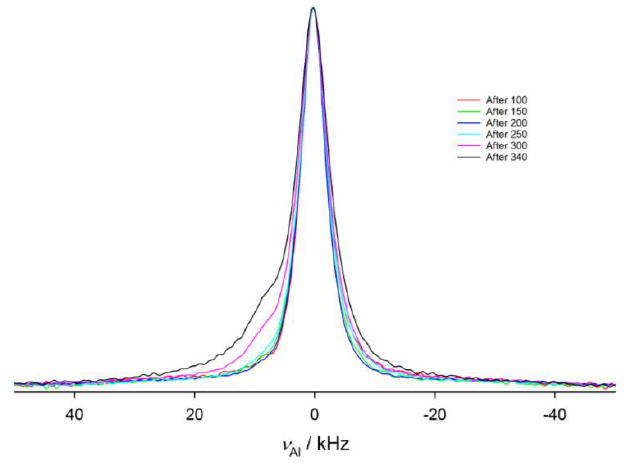
Figure 6. Non-spinning Al spectra from quintinite as a function of temperature.